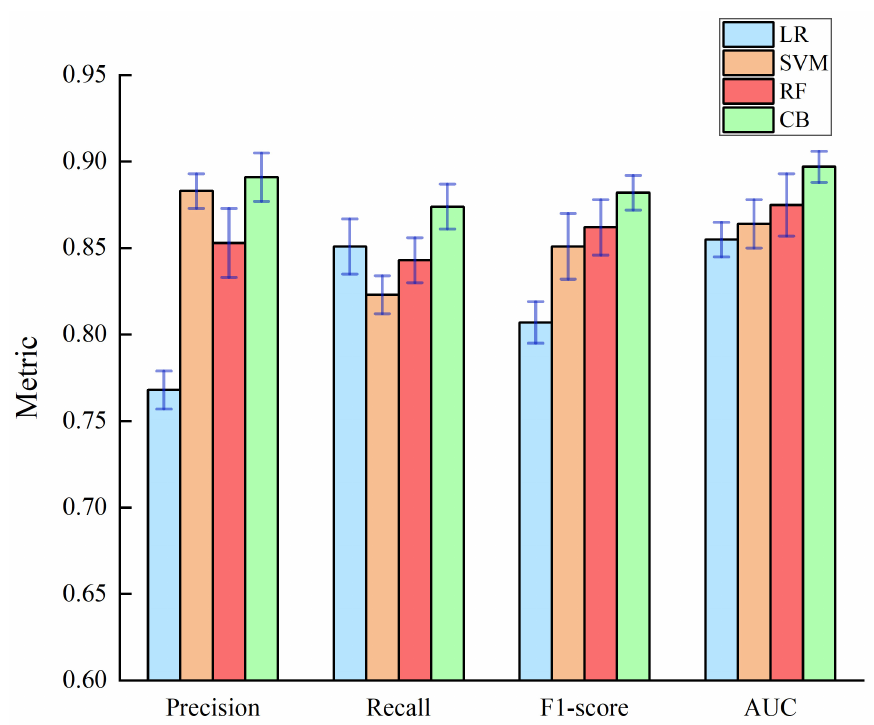
Figure 8. Standard deviations of different models in each evaluation index. Table 9. The training time of different models.